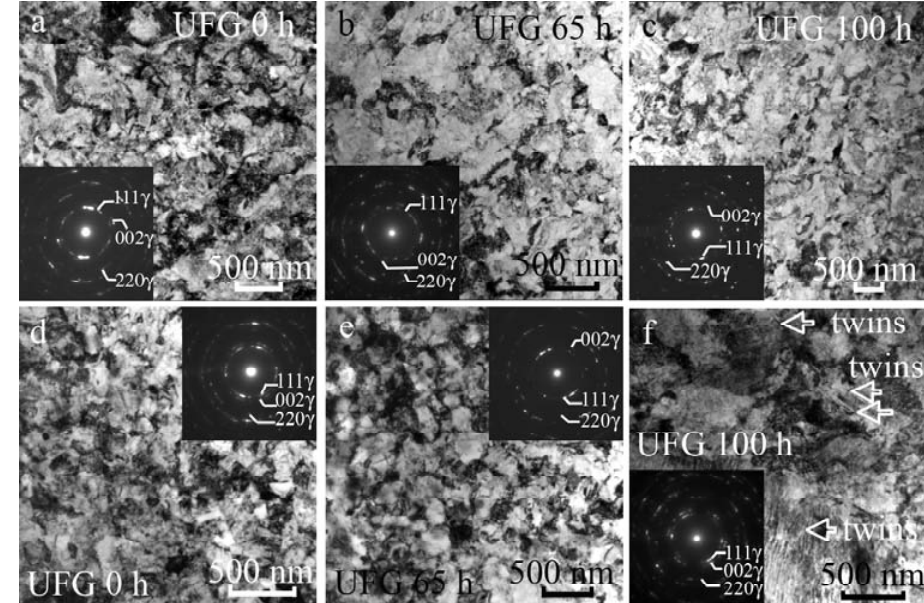
Fig. 4. The characteristic TEM bright-field micrographs and SAED patterns (inserted) in UFG-CrNiMo steel depending on hydrogen-charging regime and strain: a, b, c – specimens H-charged after ABC-pressing; d, e, f – specimens H-charged after ABC-pressing and deformed in tension to fracture. a, d – hydrogen-free specimen; b, e – hydrogen-charged for 65 hours; c, f – hydrogen-charged for 100 hours. SAED patterns is obtained from the area of 27  m 2 . TEM images correspond to surface hydrogen-saturated